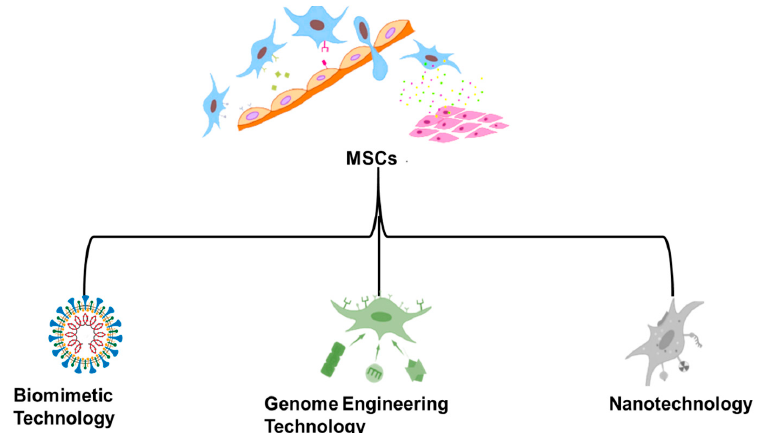
Figure 1. Modified-release medication delivery systems based on mesenchymal stem cells and their applications.